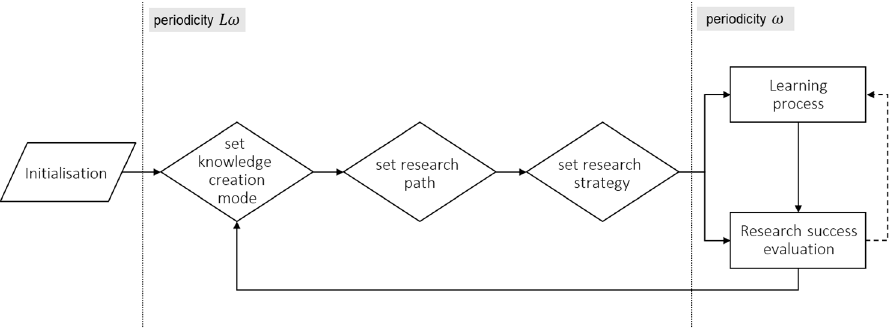
Figure 2. The agent’s knowledge creation process (simplified).